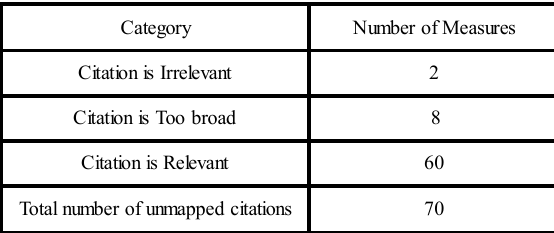
TABLE 3. DETAIL OF UNMAPPED